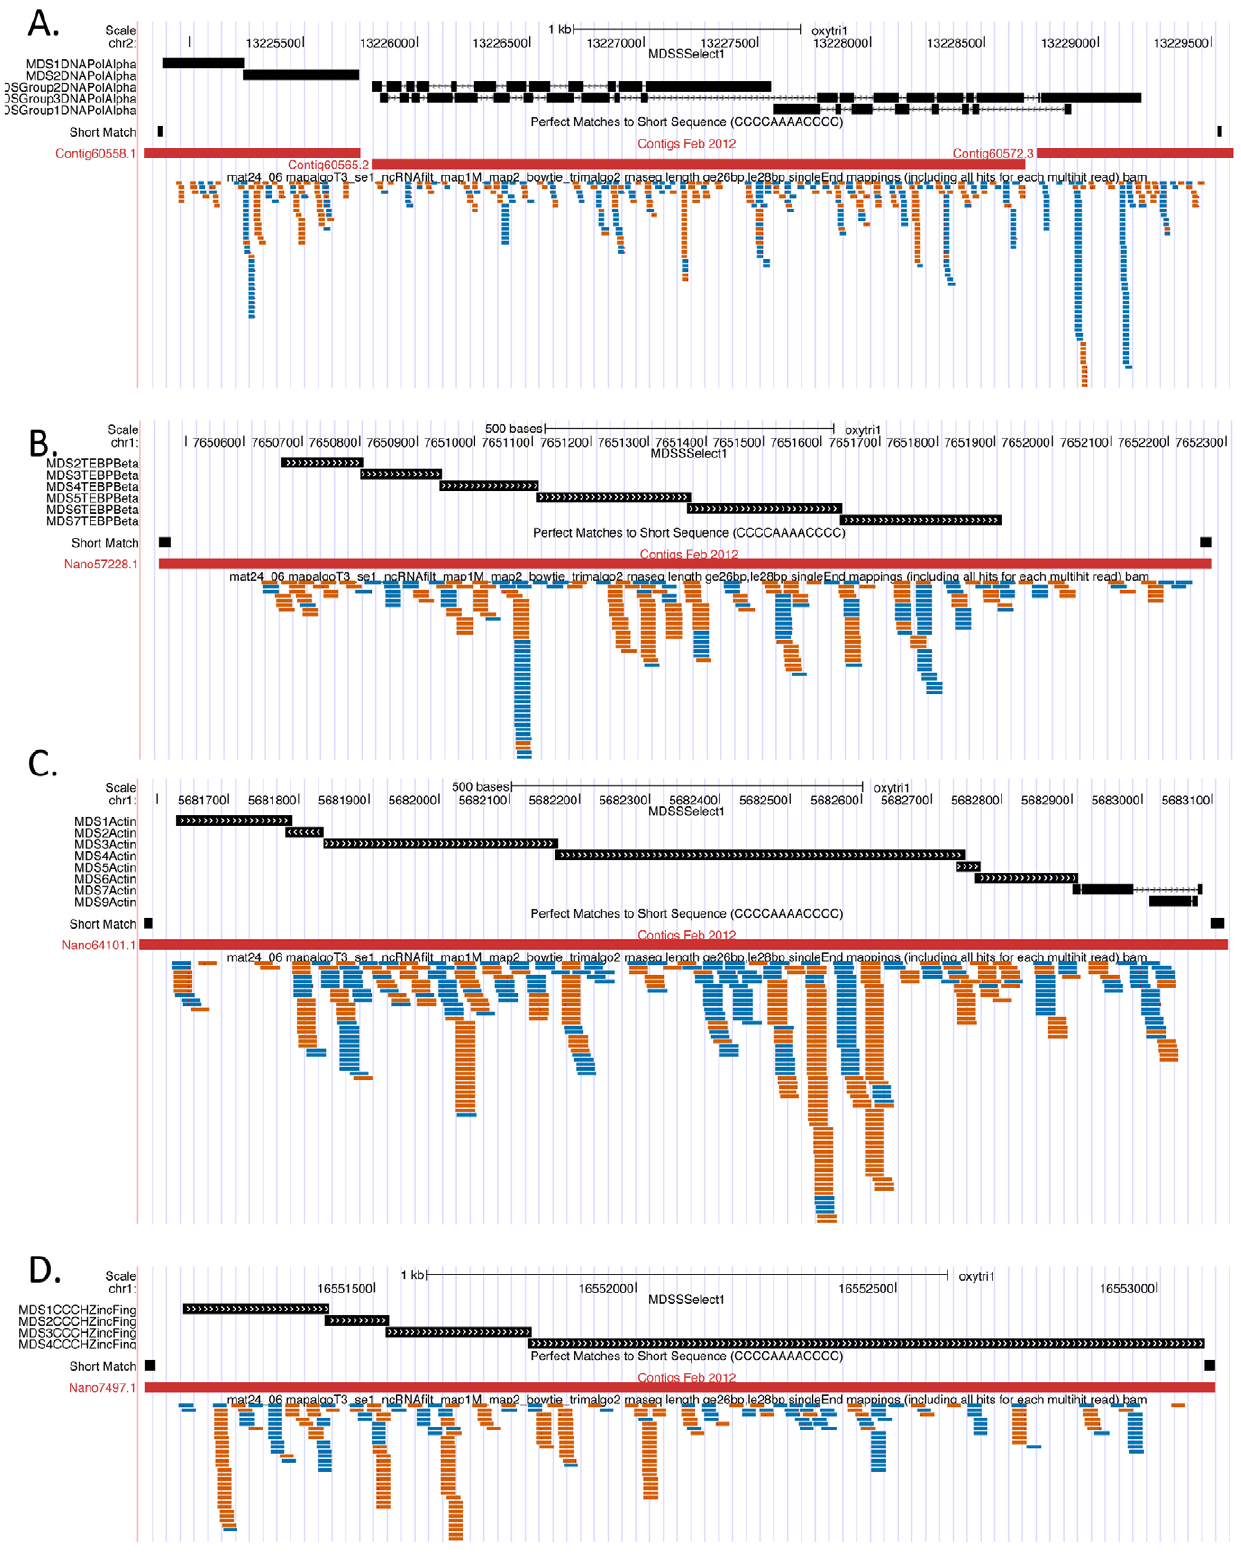
Figure 9. Screen shots of four different macronuclear genes from the Oxytricha macronuclear genome browser. In each panel, black boxes on top are a BLAT alignment of individual MDS sequences to show MDS junction location. Short match below that shows telomeric repeat locations. The red bar below that shows the nanochromosome contig extent. Blue and orange bars indicate the alignment location of 26–28 nt long small RNAs from the mat24_06 library. Plus strand alignments are in blue and minus strand alignments are in orange. A . DNA Polymerase Alpha. Note